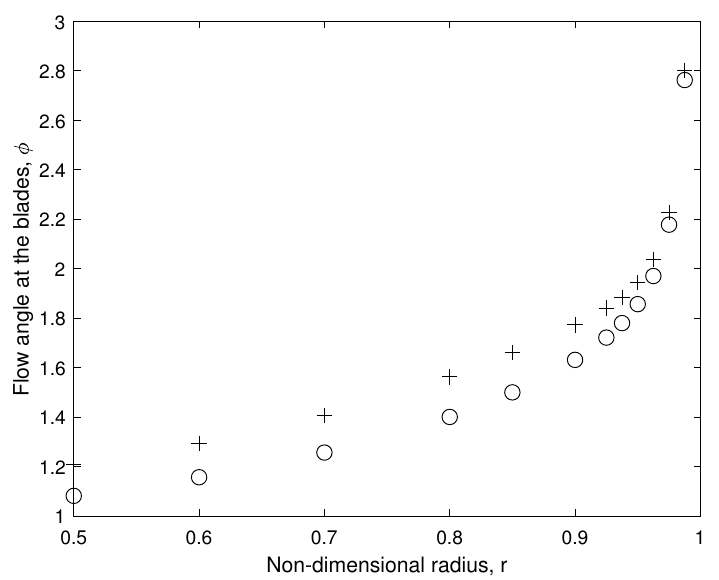
Figure 5. Flow angle, φ ,(in degrees) at the blades for the conditions of Figure 4. The integrand for the expansion integral, u 2 v 2 , is shown for the conditions of − Table 1 and p = 0.1 in Figure 6. The θ integrals used the trapezoidal rule with 360 equal − azimuthal increments. The same rule was used for the radial integral to find ∆ C T . There are apparent errors due to the singularities at x = 1 but it is reasonable to conclude that the only significant difference between the square of the averaged velocities and the average of the squares has little effect on ∆ C T or the expansion integral. Generally, the azimuthal variations in u ( θ ) are significantly less than those for the other two velocity components.